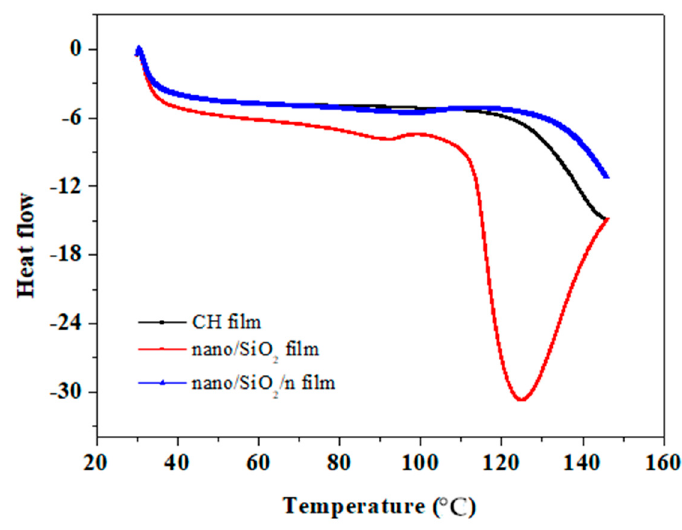
Figure 5. Thermal curves of thin novel films between 30 °C to 150 °C.